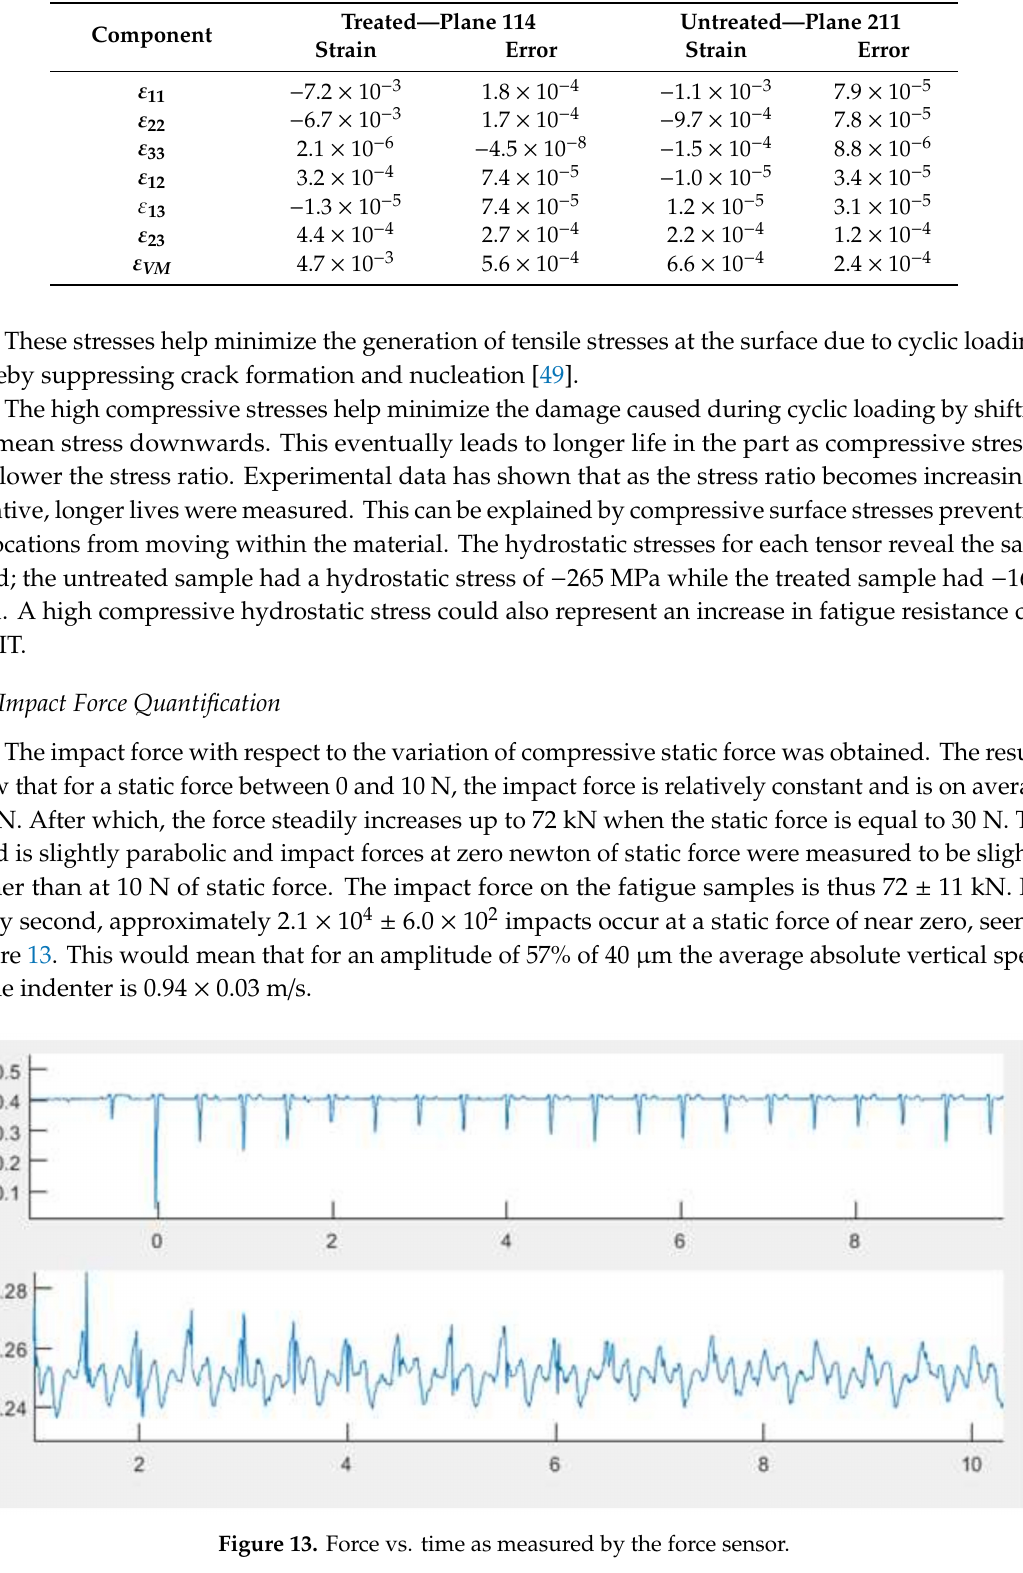
Table 3. Residual strains results.